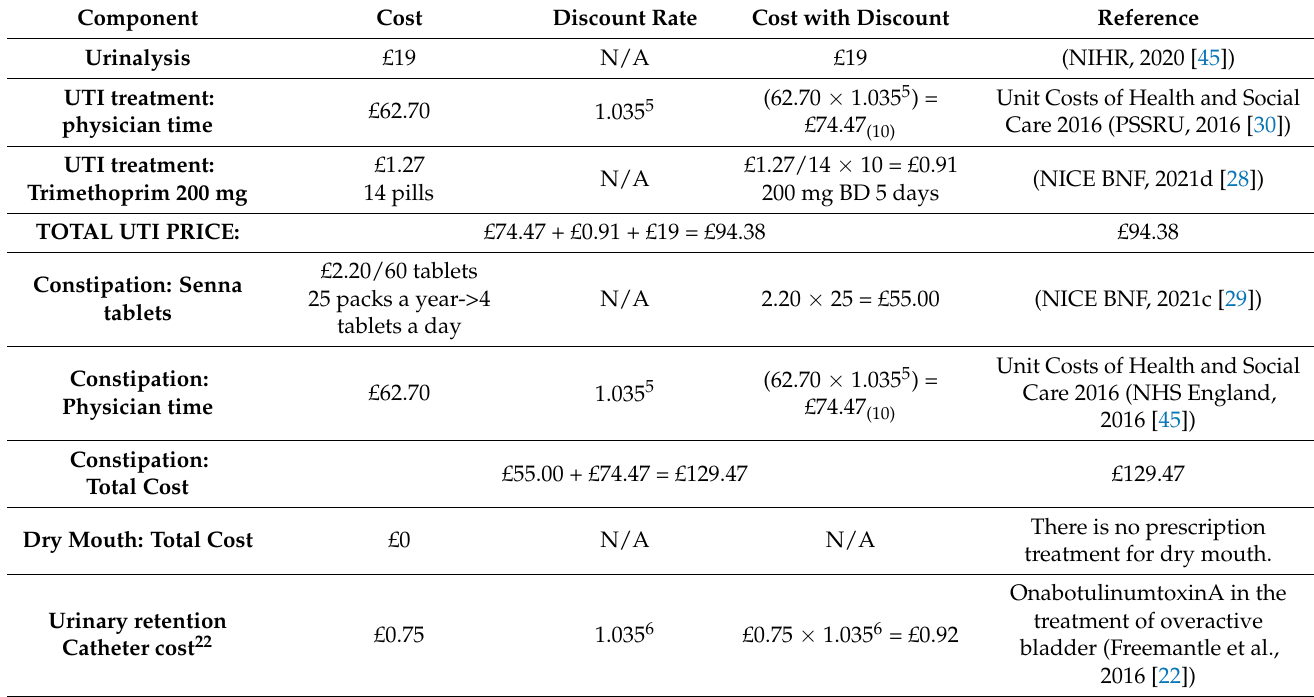
Table A5. Cost Of